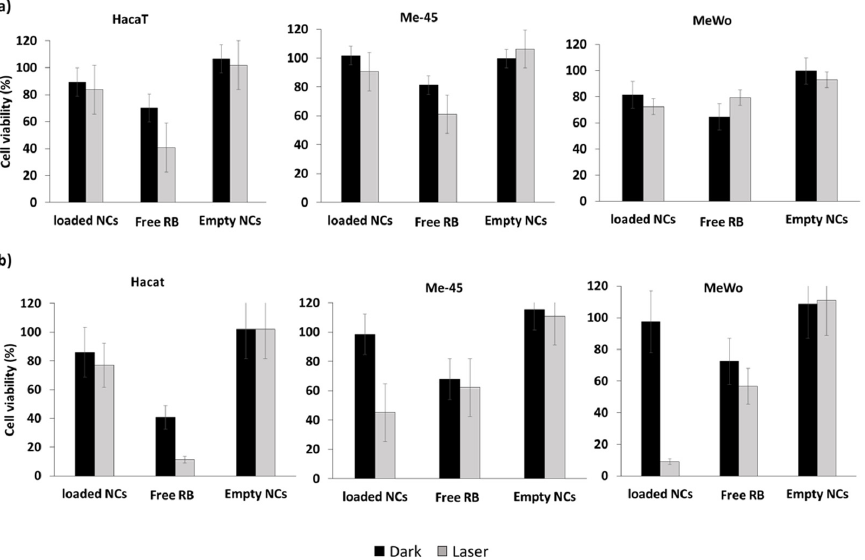
Figure 32. Cell viability of Me-45, MeWo, and HaCaT in the dark or upon exposure to laser irradiation (980 nm, 10 J/cm 2 , 6.2 W/cm 2 , 5 min) after ( a ) 24 h and ( b ) 48 h. Adapted from Bazyli ń ska et al. [75].